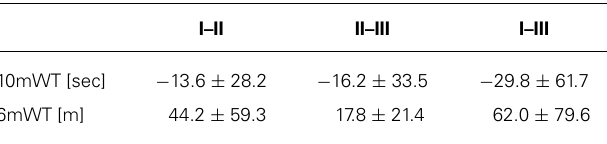
Table 1 | Pre–post condition results of 10mWT an 6mWT tests during the experimental conditions.